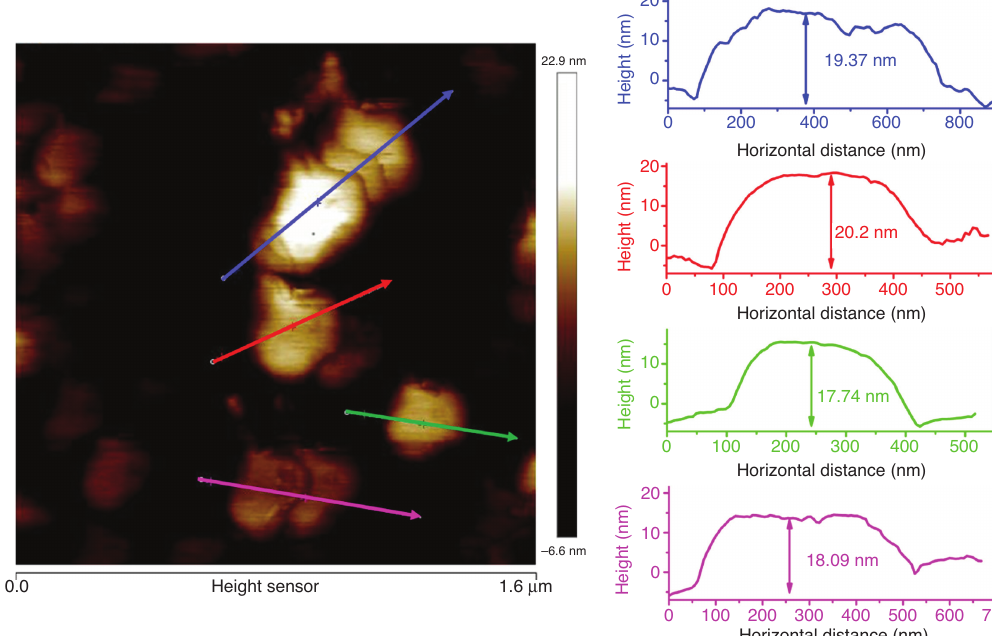
Figure 2: AFM image and the corresponding height profile.